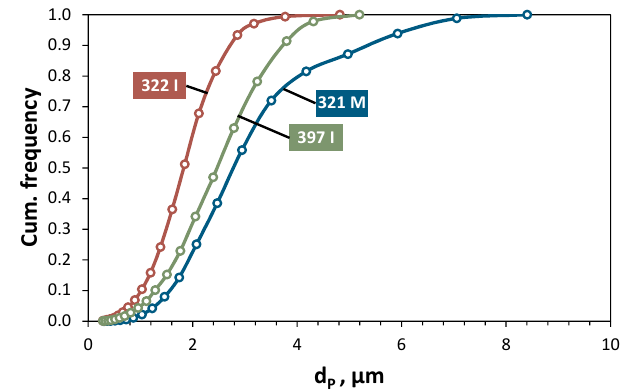
Figure 7. Volumetric cumulative distribution functions of the primary particle equivalent diameters d P for the three investigated LZ powders; curves are averaged from three SEM images.